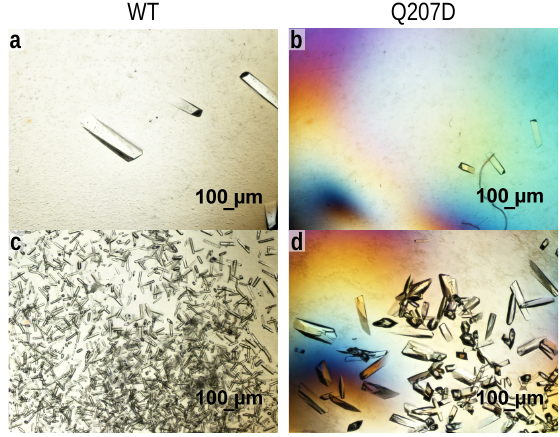
Figure 2. Crystallization experiments of Lb ADH wild type (WT) and Q207D. ( a , b ) crystallization under standard condition (5 g L − 1 Lb ADH and 75 g L − 1 PEG 550 MME at 20°C) and ( c , d ) at increased protein and PEG concentrations (10 g L − 1 Lb ADH and 100gL − 1 PEG 550 MME at 20°C). Q207D ( b , d ) showed reduced crystallizability compared to wild type ( a , c ). Microphotographs were taken after 24h and are representative of the ten crystallization droplets for each variant and each